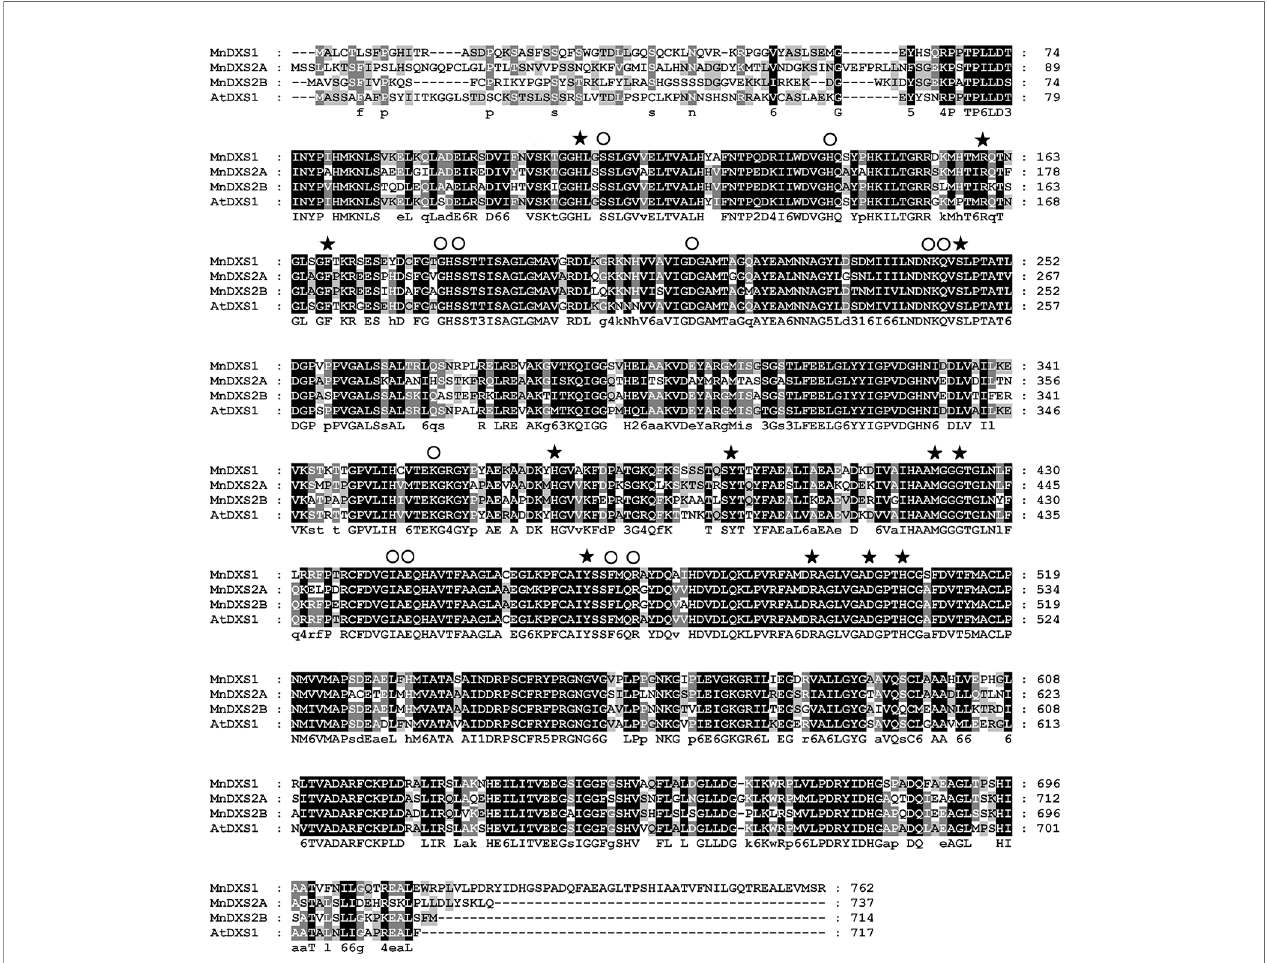
FIGURE 1 | Alignment of the MnDXS1, MnDXS2A, and MnDXS2B amino acid sequences with the Arabidopsis thaliana DXS1 protein. Residues in the (GAP-binding and TPP-binding domains are marked with solid stars and circles,